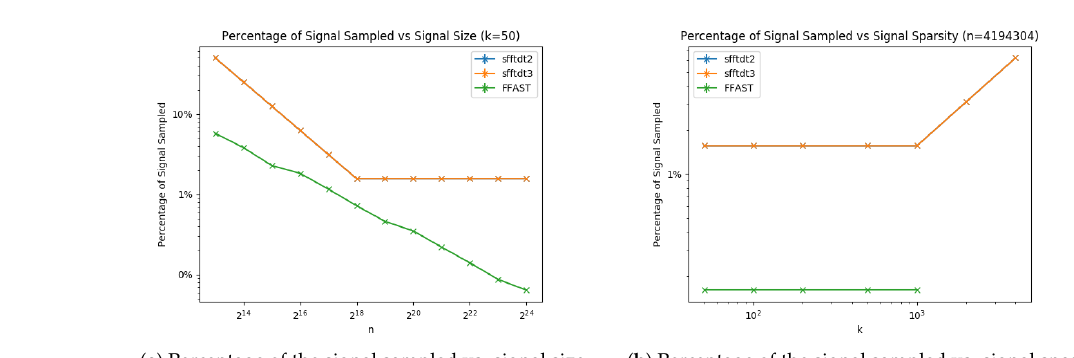
Figure 8. Percentage of the signal sampled of three algorithms using the aliasing filter, including the sFFT-DT2.0, sFFT-DT3.0, and R-FFAST algorithms in the general sparse case.